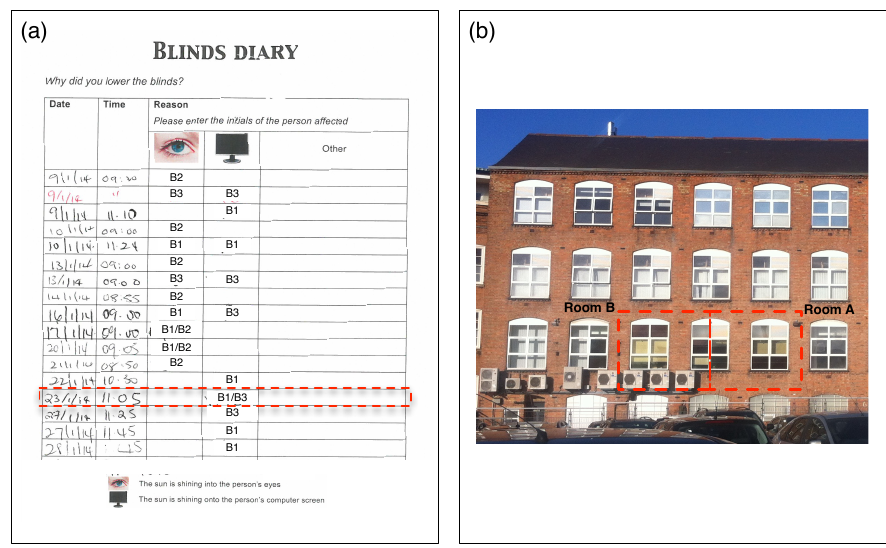
Figure 4. ( a ) Blinds diary sheet for January 2014 (the example day is highlighted, and the original entries of participant initials have been replaced with their study IDs); ( b ) Facade photo showing both case study offices from the outside on the example day at 12:32.